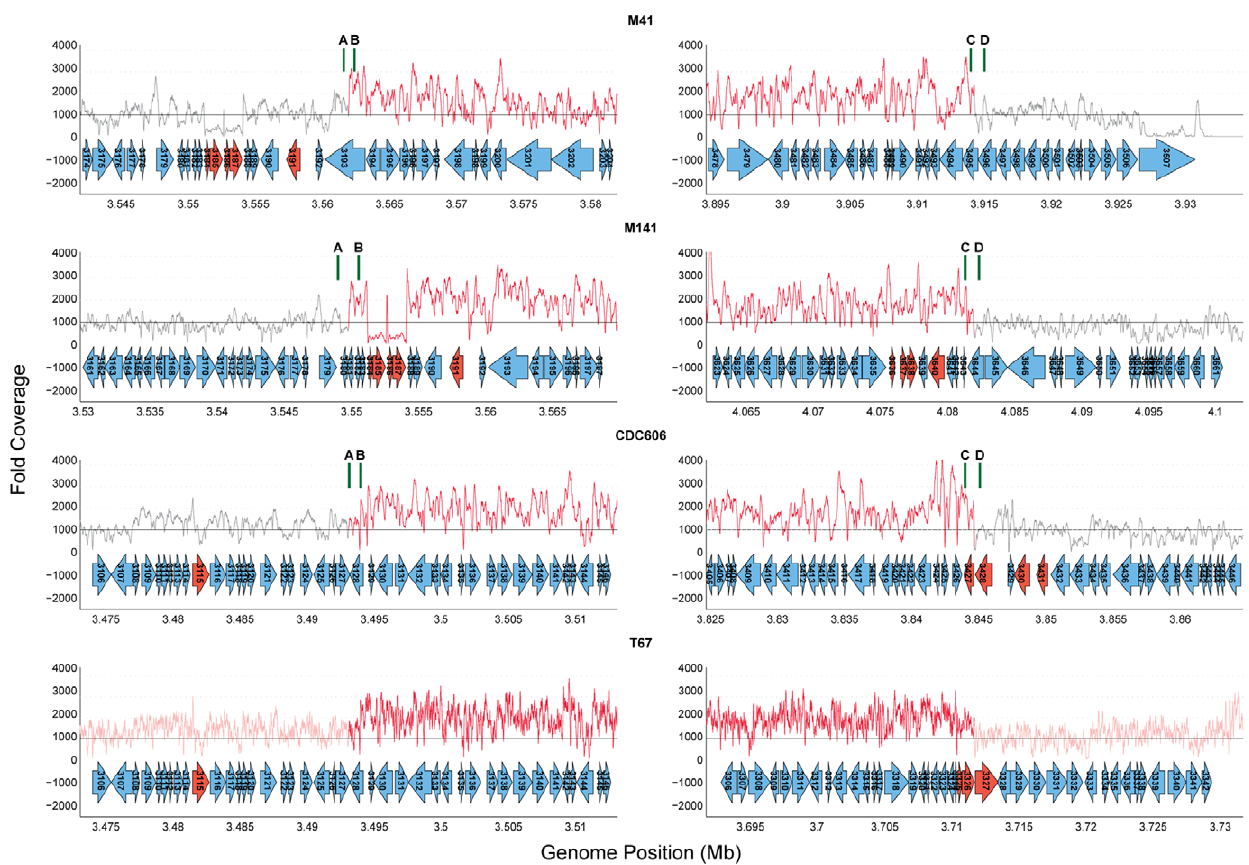
Figure 4. Coverage plots around duplication boundaries. Each plot shows the fold coverage for the alignment of the corresponding strain to H37Rv around the upstream (left column) or downstream (right column) duplication boundaries. Color coding for coverage plots is as in Figure 2. Genes in red are predicted repeats or transposable elements in H37Rv. Vertical green bars indicate the positions of PCR primers used (see Table 3).